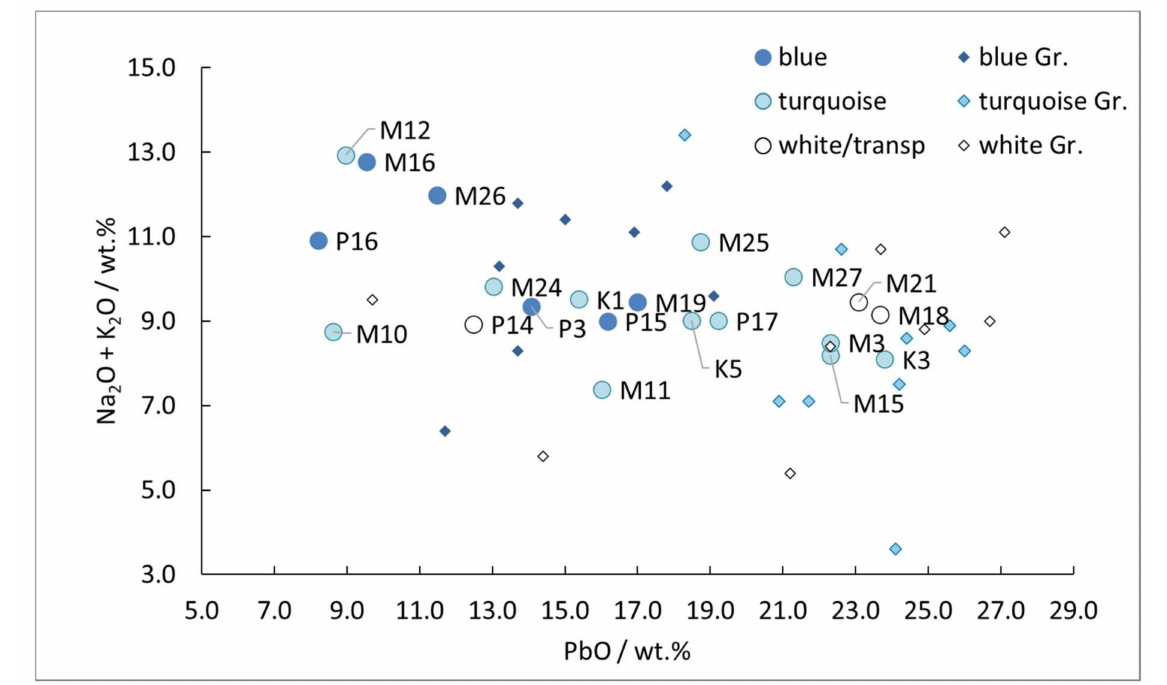
Figure 5. Scatter plot of the SEM/EDX results of glazes with mixed lead alkaline composition. “Gr”: analysis by Gradmann.